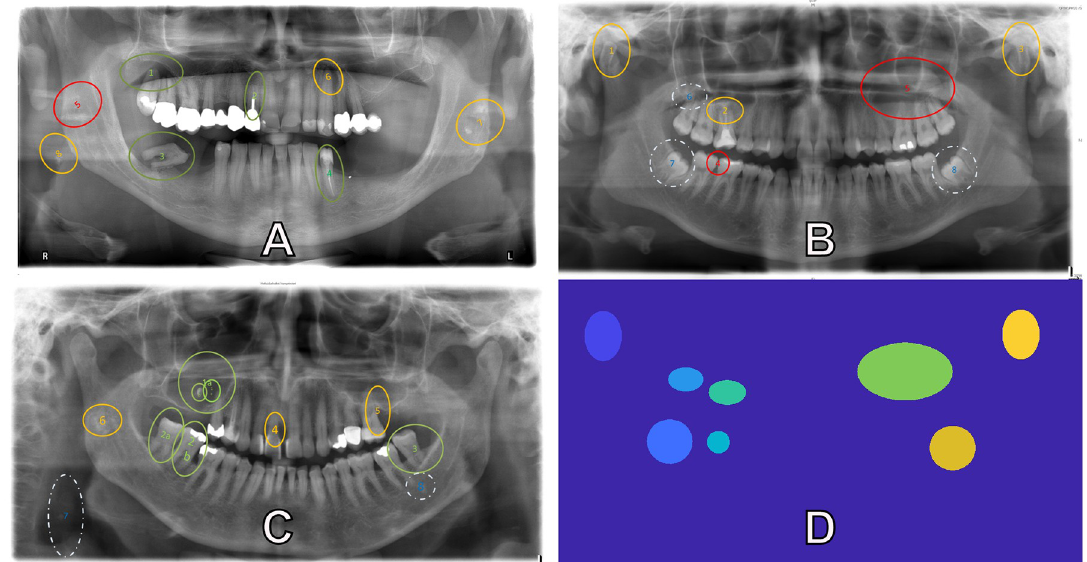
Fig 2. OPTs with pre-determined ground truth. Example of the OPTs used in the experiment. Pre-determined ground truths are indicated by the ellipses and their colors indicate the level of difficulty each anomaly is: Green (least difficult), yellow (intermediary), red (most difficult) and white (nature of difficulty unclear). Image (D) is the ground truth map for image (B). Each anomaly is segmented and given a distinguishing integer.